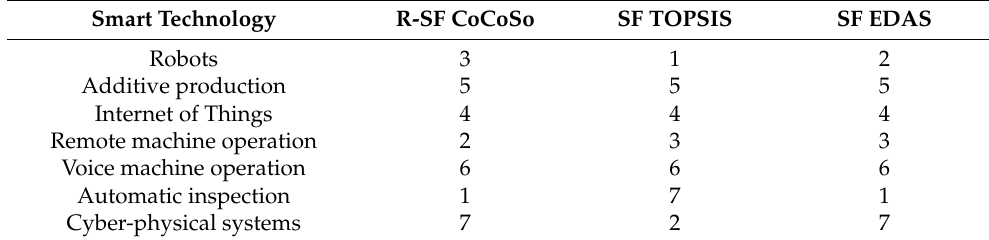
Table 5. The comparison ranking